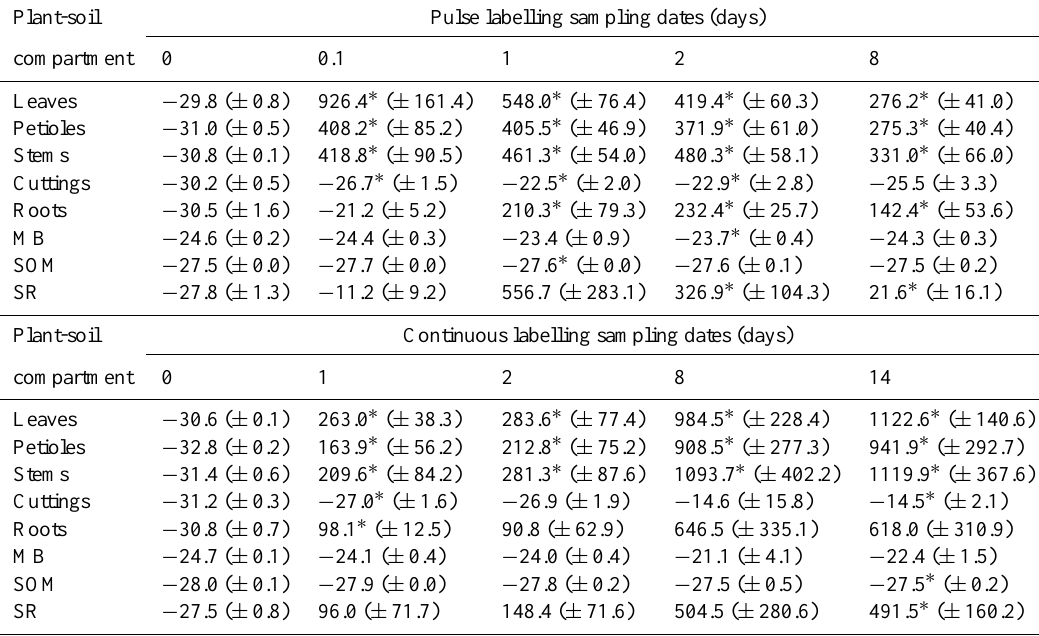
Table 1. δ 13 C signal detection in the plant-soil compartments. δ 13 C values ± one standard deviation (in ‰) of the plant tissues, microbial biomass (MB), soil organic matter (SOM) and the soil respiration (SR) are indicated for the five sampling dates (in days after the pulse or during the continuous